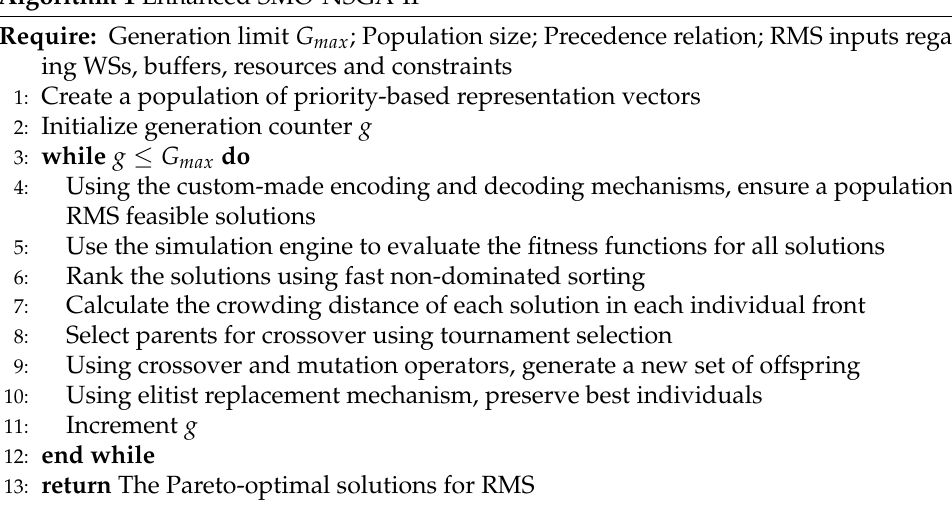
Algorithm 1 Enhanced